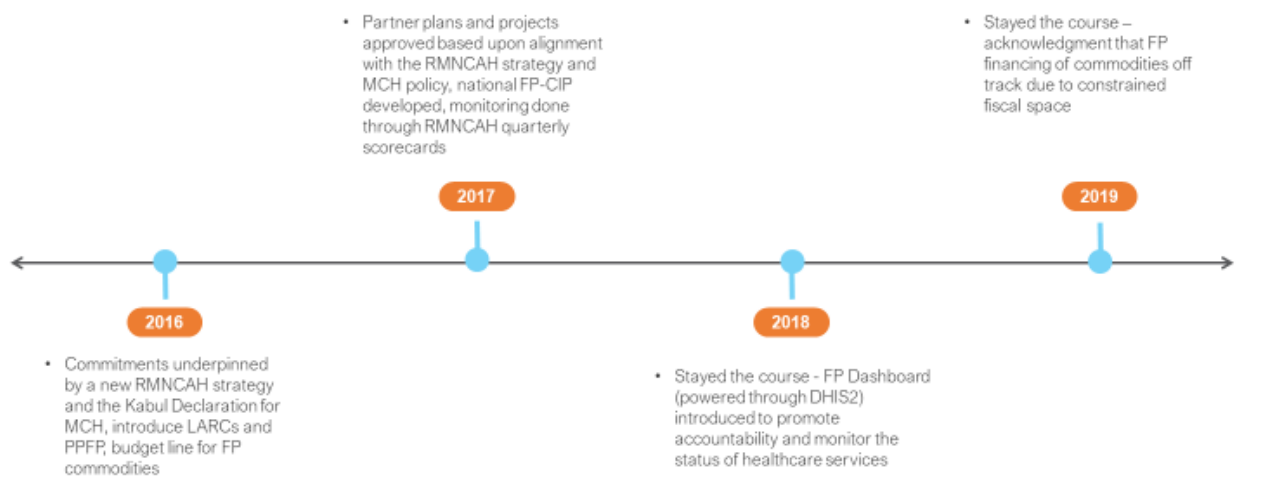
Figure 2. Afghanistan FP2020 commitments and timeline. RMNCAH – reproductive, maternal, newborn, child and adolescent health; MCH – maternal and child health; PPFP – post-partum FP; CIP – costed implementation plan; DHIS2 – District Health Information System